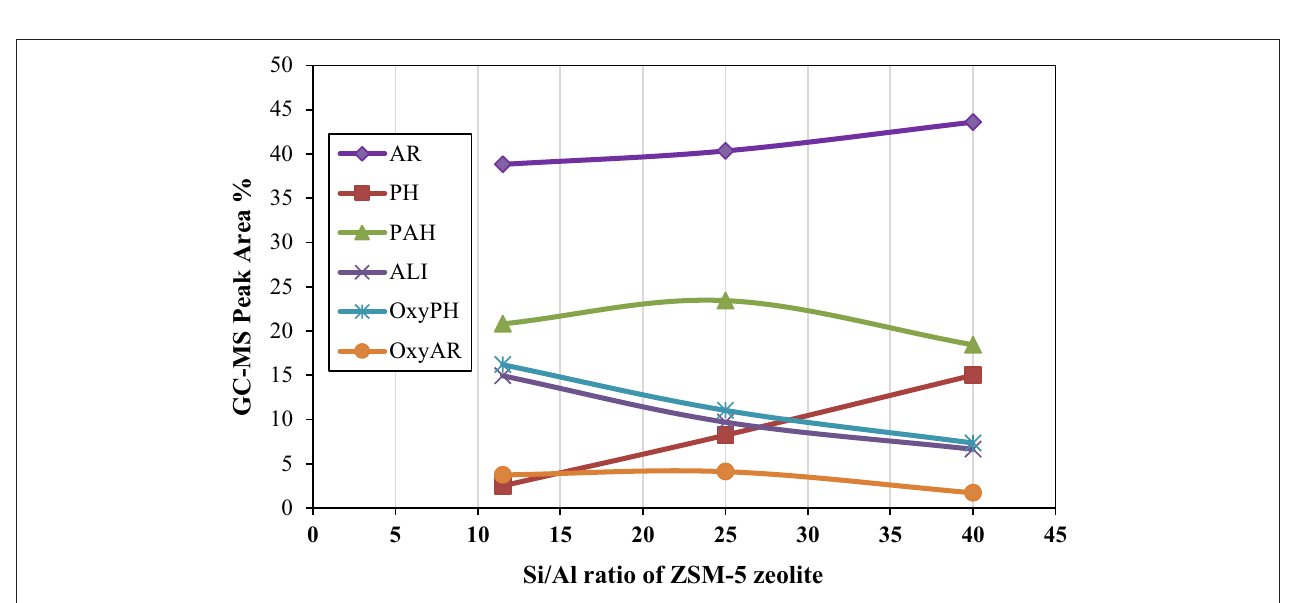
FIGURE 9 | Correlation between the Si/Al ratio of ZSM-5 zeolite with the relative concentration of the most representative groups of compounds in the bio-oil derived by catalytic fast pyrolysis (CFP) of kraft lignin at 600 ◦ C and C/L = 4 (AR, mono-aromatics; PH, phenol and alkyl-phenols; PAHs, polycyclic aromatic hydrocarbons; ALI, aliphatic hydrocarbons, OxyPH, oxygenated phenolics; OxyAR, oxygenated aromatics).